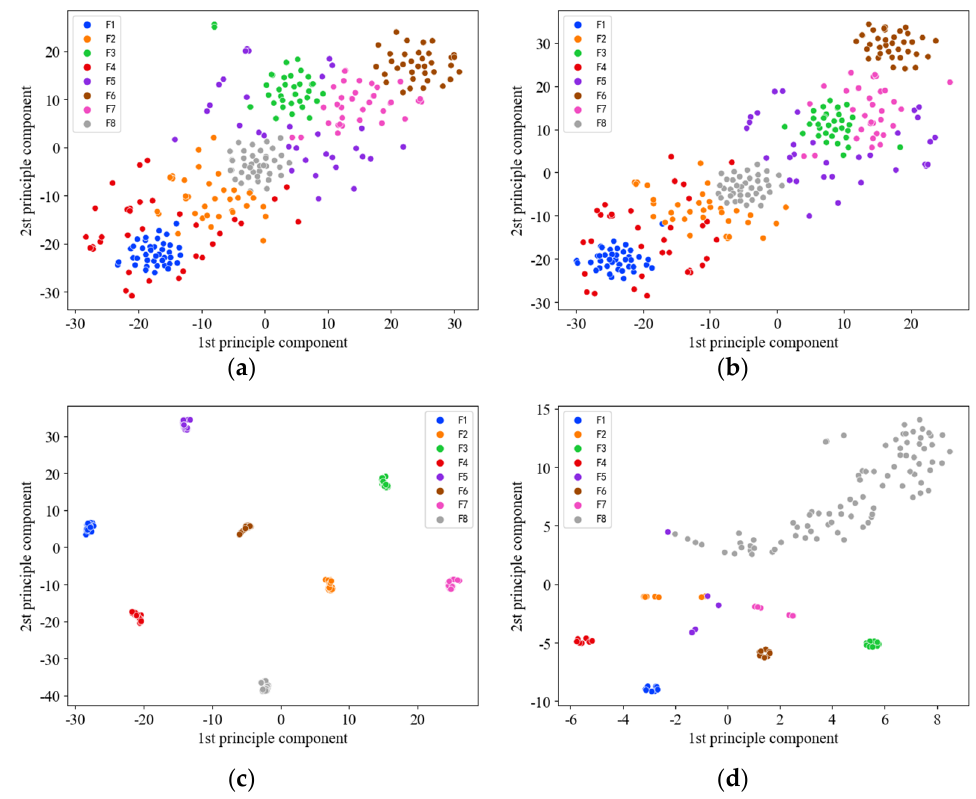
Figure 12. The visualization by t − SNE of the learned features in the Conv2D layer and Fully connected layer of Dataset 3: ( a ) layer C1 in the balanced Dataset 3; ( b ) layer C2 in the balanced Dataset 3; ( c ) layer F1 in the balanced Dataset 3; ( d ) layer F1 in the imbalanced Dataset 3.